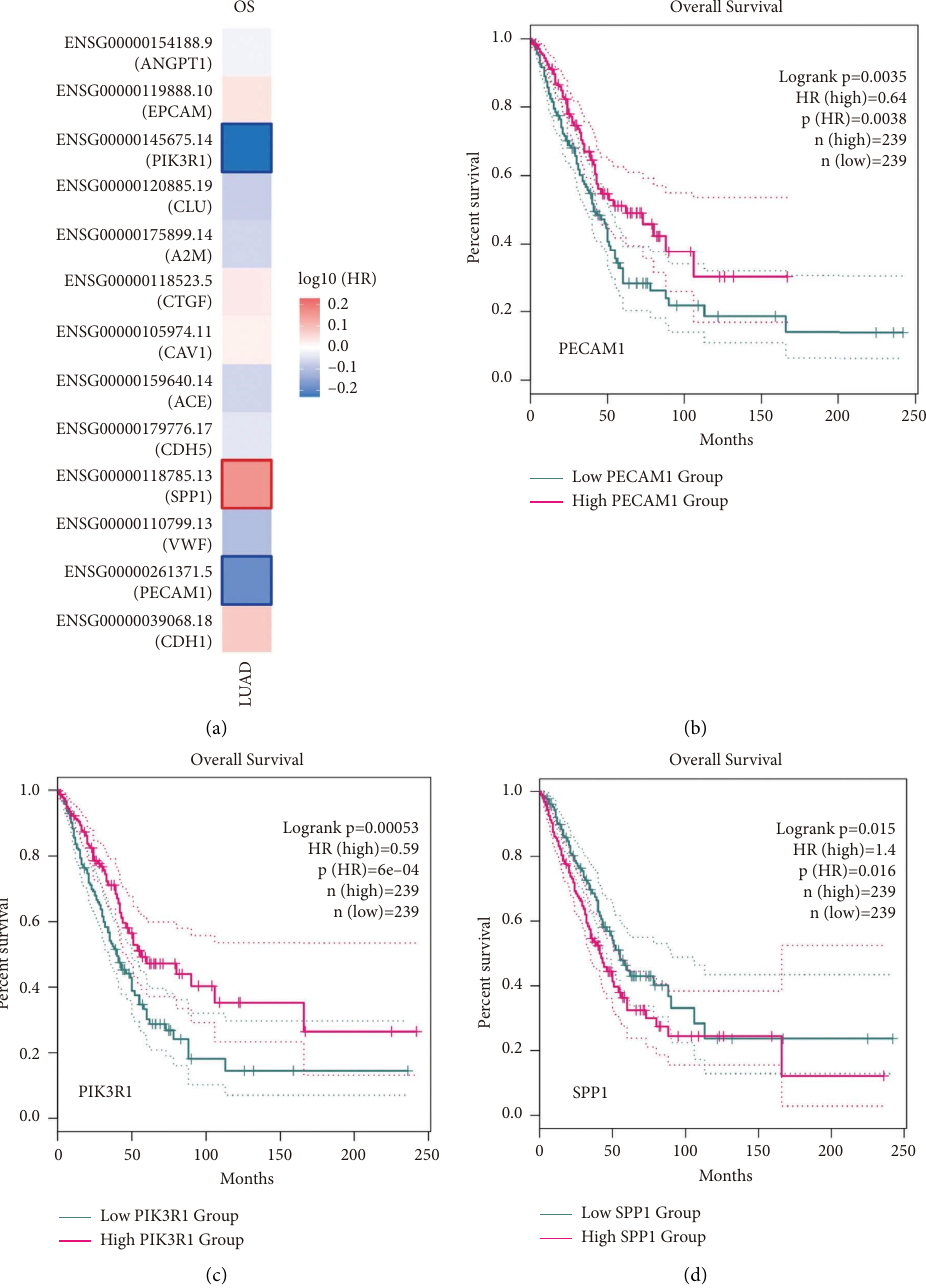
Figure 7: (a) Survival analysis of 14 hub genes in lung adenocarcinoma based on GEPIA. (b–d) We found that three genes (PECAM1, PIK3R1, and SPP1) were signifcantly correlated with overall survival. P < 0 . 05 was considered as statistically